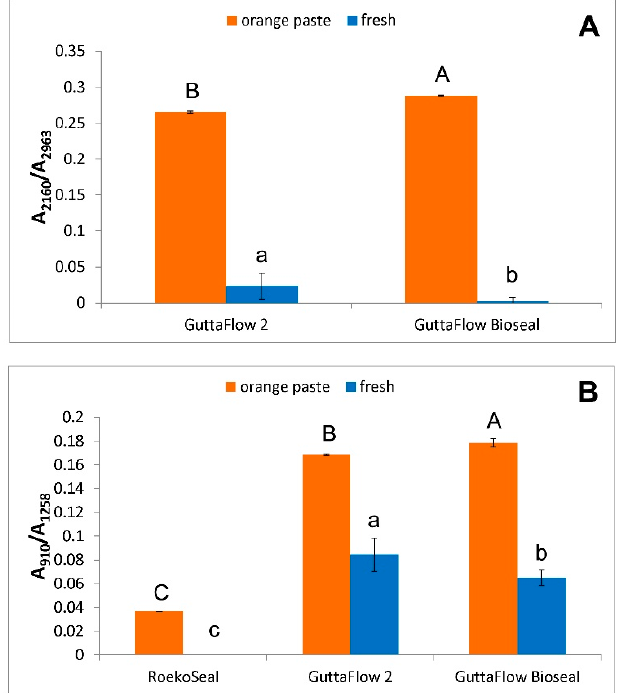
Figure 2. A 2160 /A 2963 ( A ) and A 910 /A 1258 ( B ) absorbance ratios (average ± standard deviation) as calculated from the IR spectra of the orange paste and fresh (i.e., just mixed) samples of the commercial sealers under study. The different capital letters in each histogram represent statistically significant differences ( p < 0.05) between orange pastes and small letters between the fresh samples.